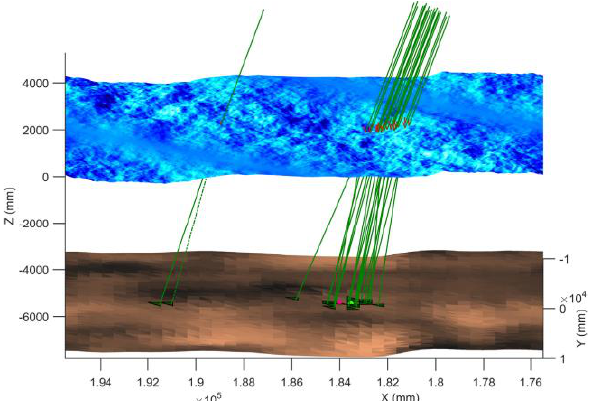
Figure 3: Interaction of an infinitesimally thin (left) and a finite diameter laser pulse (right) with a simulated wave pattern, effects on bottom point determination (Westfeld et al., 2017)